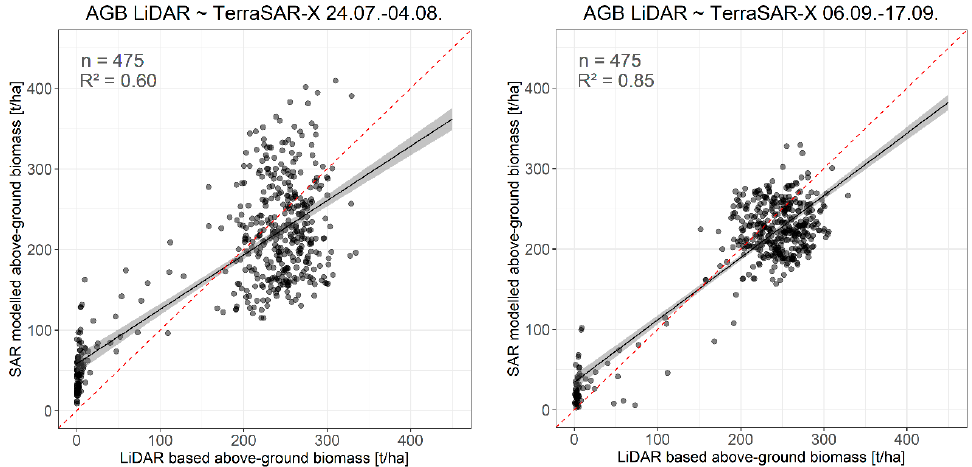
Figure 9. Correlation of reference LiDAR AGB and modelled TS-X AGB based on an interferogram from 24.07.–04.08. (left) and 06.09.–17.09. (right). Red dashed line = 1:1 line; black line = linear trend including confidence